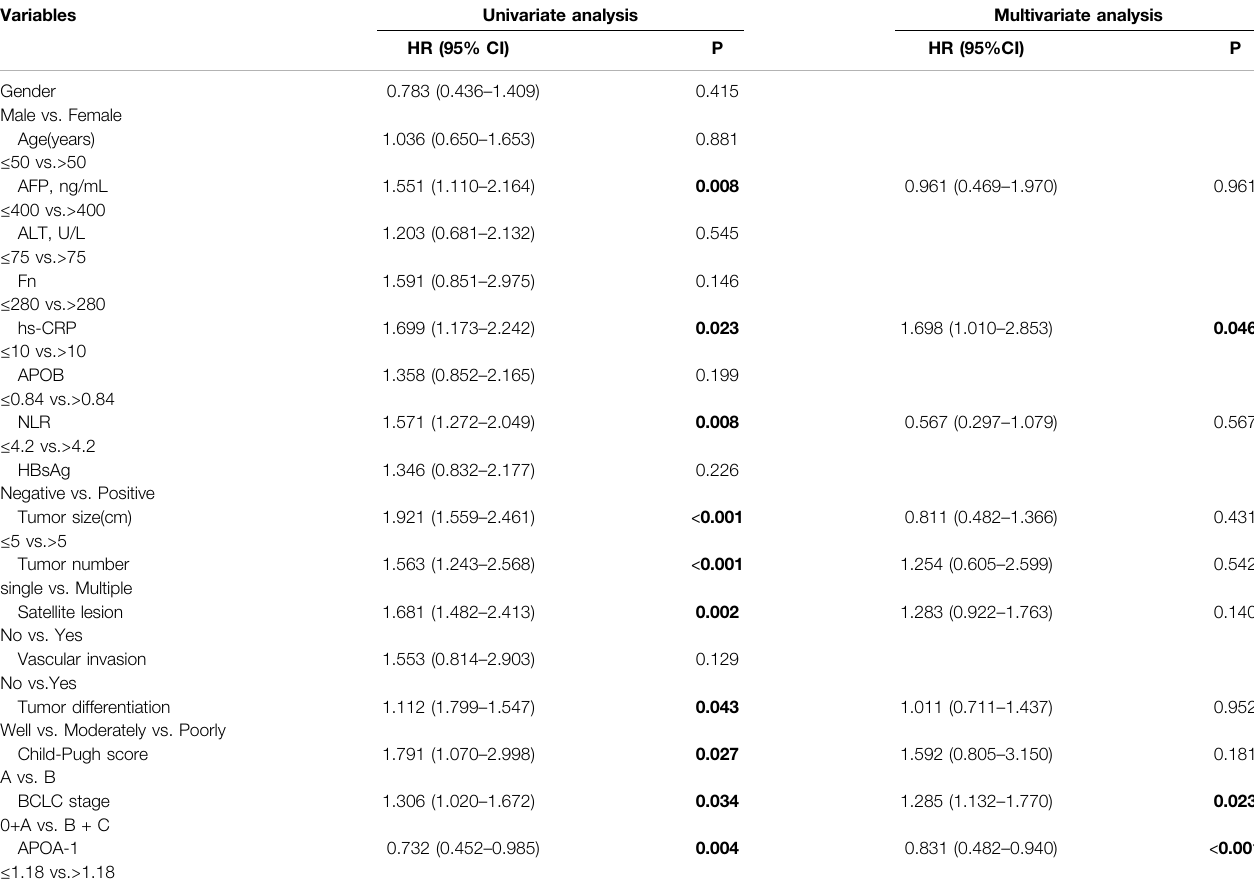
TABLE 3 | Univariate and multivariate cox hazards analysis for Overall survival in 316 patients with HCC.